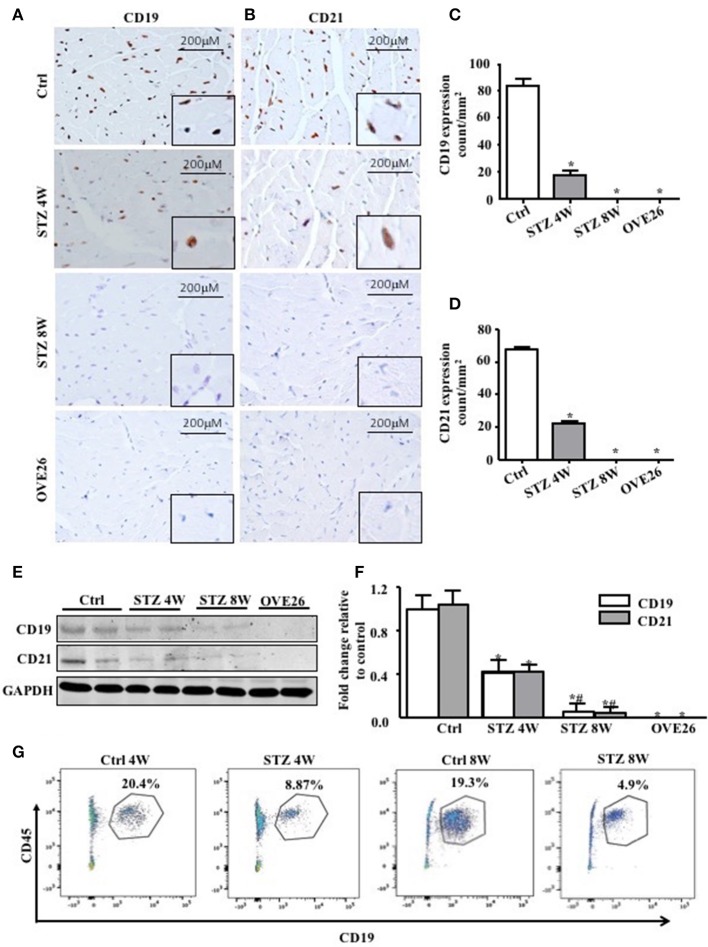
Immunohistochemical analysis of B cell expression and quantification in diabetic mice heart. (A,C) CD19 expression and quantification, (B,D) CD21 expression and quantification. (E,F) Immunoblot representation of B cell markers CD19 and CD21 expression and quantification. (G) Flow cytometric analysis of B cell markers expression at 4W and 8W in control and diabetic heart mice. Data are expressed in mean ± SEM (*p < 0.05 as biological significant level, Ctrl vs. STZ), n = 6. #p < 0.05 as biological significance level, STZ 4W vs STZ 8W.